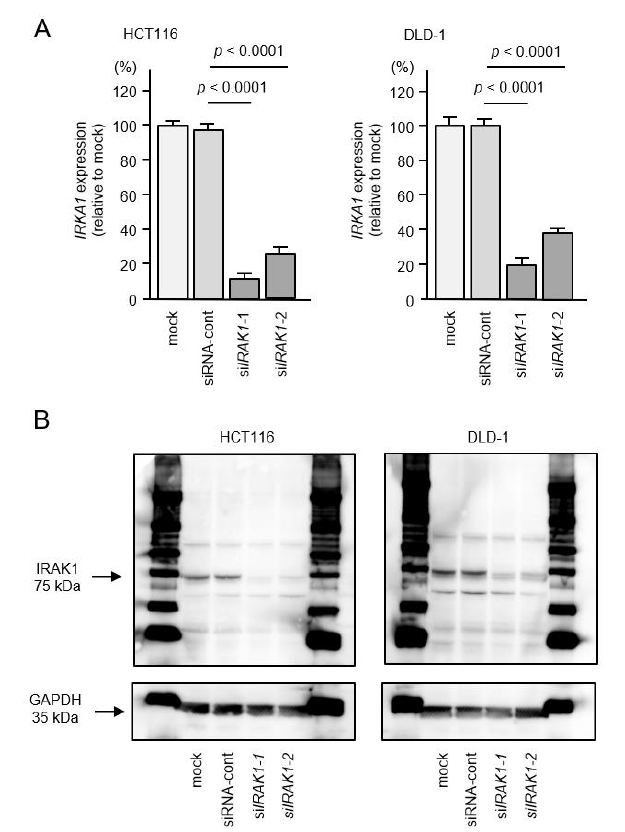
Figure 8. Knockdown efficiencies of IRAK1 expression by siRNAs in colorectal cancer (CRC) cells. Two different siRNAs, siIRAK1 -1 and siIRAK1 -2 were used. ( A ) Real-time PCR showing significantly reduced expression of IRAK1 mRNA 72 h after either s iIRAK1 -1 or siIRAK1 -2 transfection in CRC cells (HCT116 and DLD-1). Expression of GAPDH was used as an internal control. ( B ) Western blots showing reduced expression of IRAK1 protein 72 h after siIRAK1 -1 or siIRAK1 -2 transfection in CRC cells. Expression of GAPDH was used as an internal control.